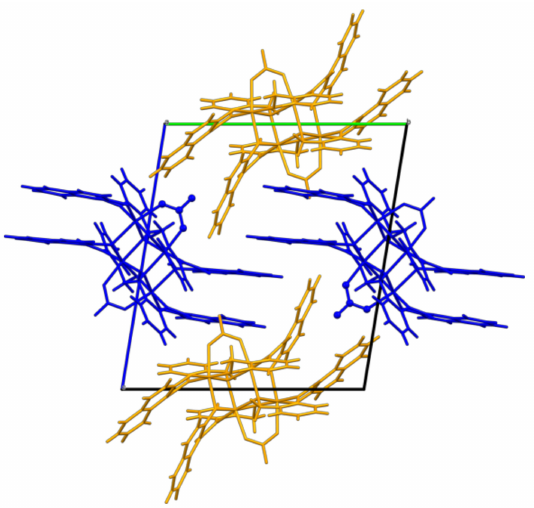
Figure 4. Packing view along the a -axis of 2 . Crystal solvents are omitted for clarity. Complex 2A and 2B are color coded with blue and orange, respectively.